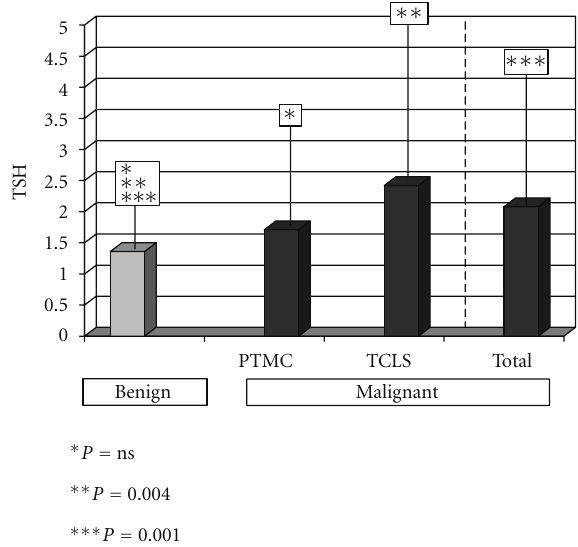
Figure 1: TSH concentrations in the di ff erent study groups. PTMC: papillary thyroid microcarcinoma and TCLS: thyroid carcinoma of larger